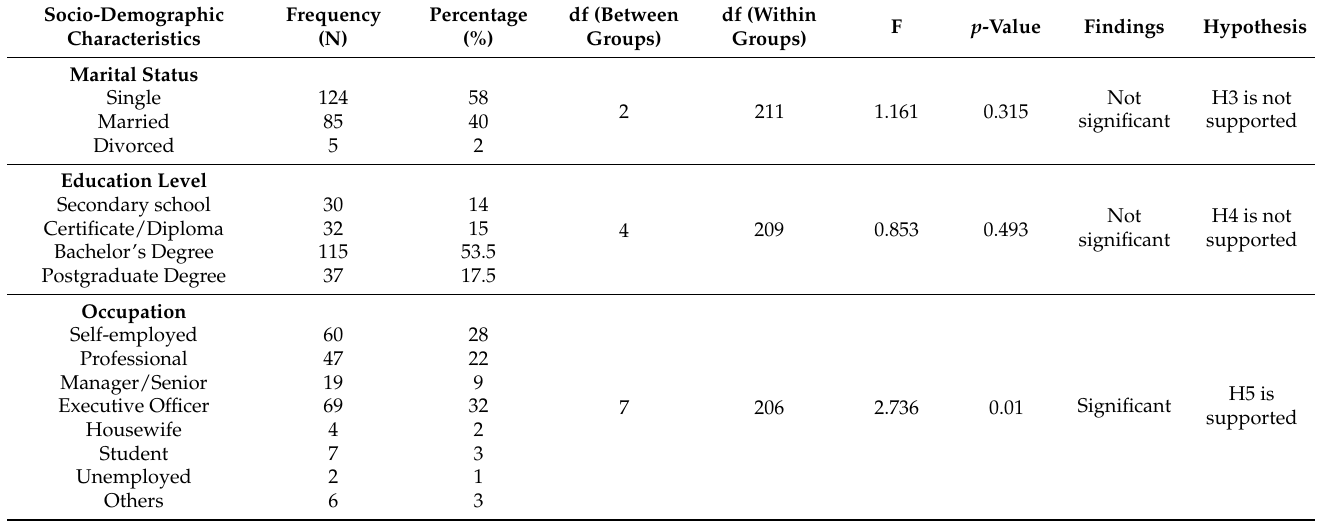
Table 3. ANOVA results for other socio-demographic